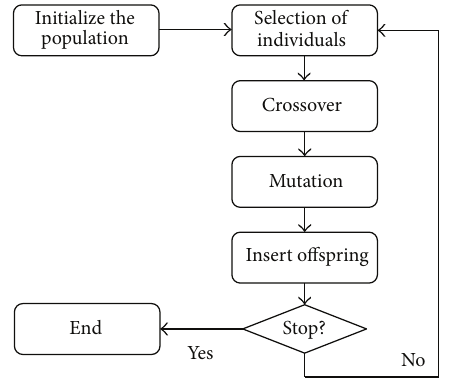
Figure 1: General outline of the operation of an evolutionary